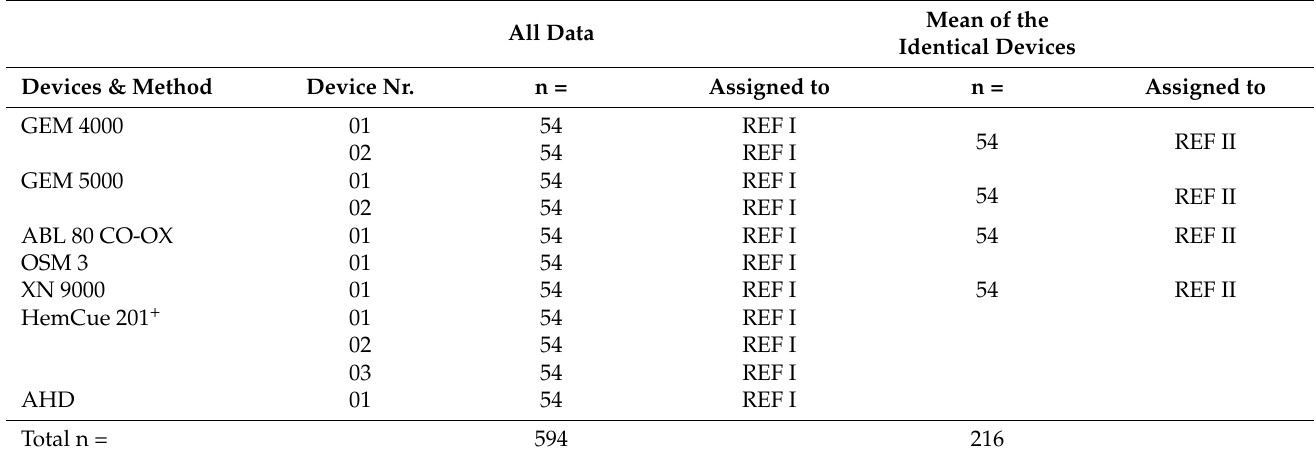
Table 2. Data processing and assignments to the references (REF I + II).